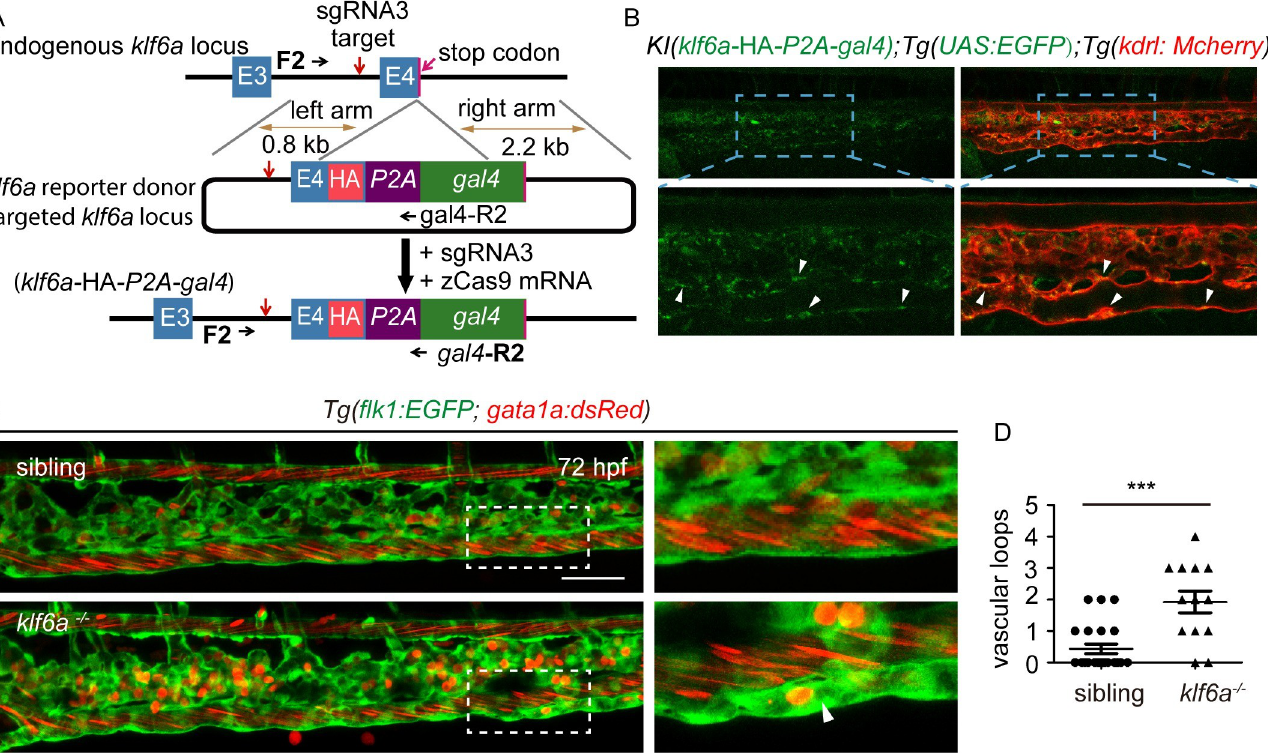
Fig 3. Transcription factor klf6a regulates CV pruning in zebrafish. (A) Generation of KI (klf6a - HA -P2A-gal4) fish. (B) Expression pattern of KI(klf6a -HA - P2A-gal4) fish. Arrowheads indicate the location of klf6a at the vasculature. (C) Role of klf6a in CV pruning in zebrafish embryos. Boxes show enlarged images of the CV. The arrowhead indicates the unpruned vessel. Scale bar: 50 μ m. (D) Quantification of vascular loops in the sibling and klf6a -/- : sibling, n = 23 embryos; klf6a -/- , n = 13 embryos. P < 0.001. Student’s unpaired two-tailed t test.